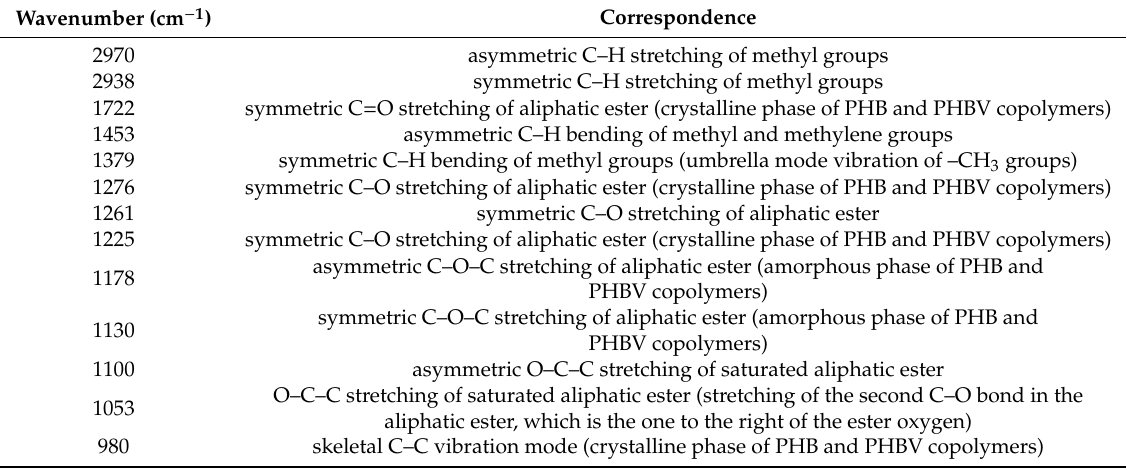
Table 2. Attributions of the main infrared peaks of the poly(3-hydroxybutyrate) (PHB) and PHBV copolymers.